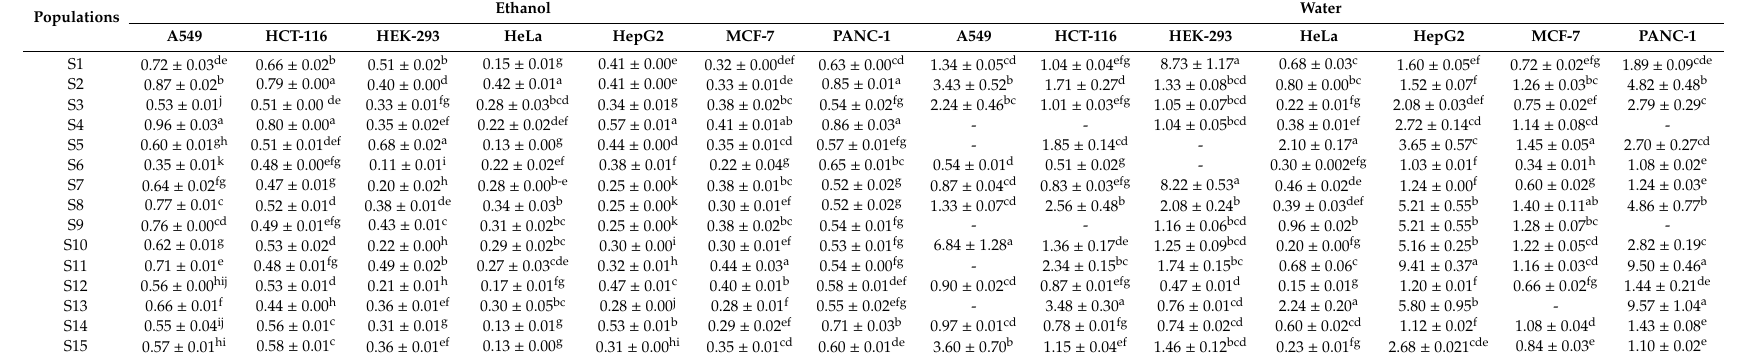
Table 5. The antiproliferation e ff ects (IC 50 values) of ethanol and water extracts of C. paliurus leaves on di ff erent cell